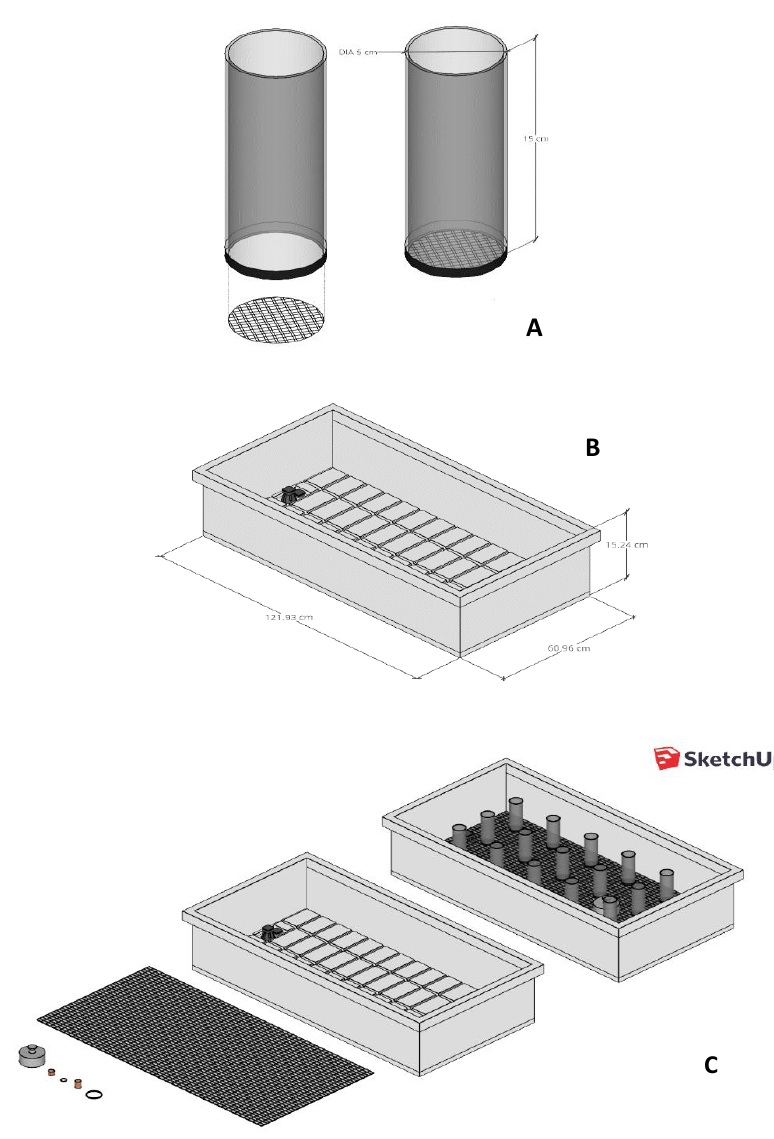
Figure 2. Subirrigation system. (Left, right, bottom) ( A ) Cylinder (15 cm × 5 cm) with rubber pressure plate ring at base with mesh screen with DIA representing the cylinder diameter. ( B ) Ebb and flood subirrigation system. ( C ) Separated full system (from left to right) with central weight, three copper leveling pipes, large steel ring (for raising wire screen off surface), black wire mesh screen, fully assembled system.